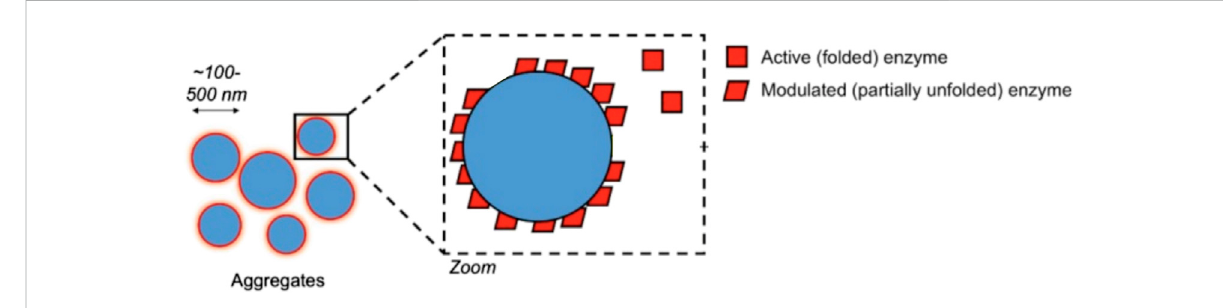
FIGURE 5 Non-selective aggregation inhibition model. Figure modi fi ed from Auld et al. (2017) for clarity under CC BY-NC-SA